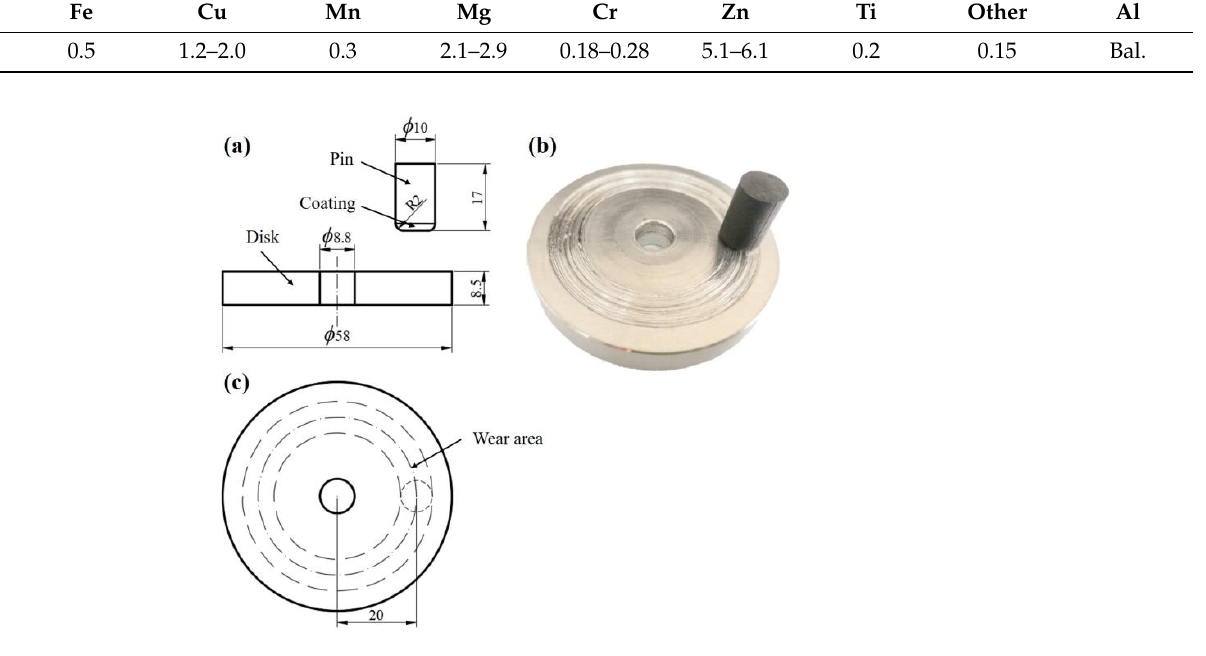
Figure 4. Schematic diagram of thermal fatigue testing apparatus. Table 2. Parameters of the thermal fatigue test.